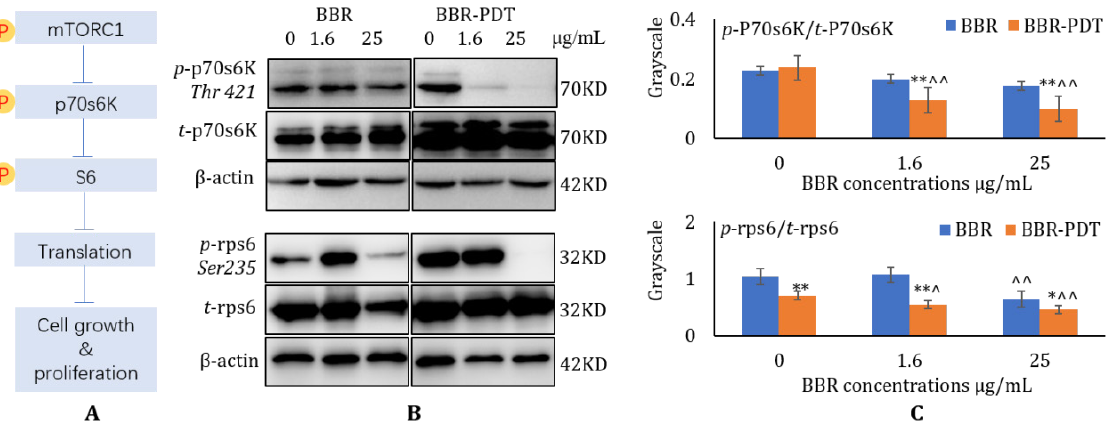
Figure 5: Effects of BBR-mediated PDT on downstream of mTORC1. (A). Diagram of the mTORC1 pathway. (B). Representative Western blot analysis. (C). Densitometric quantification of the corresponding Western blot analysis. Concentrations of BBR were 0, 1.6 and 25 μg/mL, PDT was performed after 6 hours co-incubation. Means ± SD, n = 3, * P < 0.05, ** P < 0.01, vs BBR group. ^ P < 0.05, ^^ P < 0.01, vs concentration